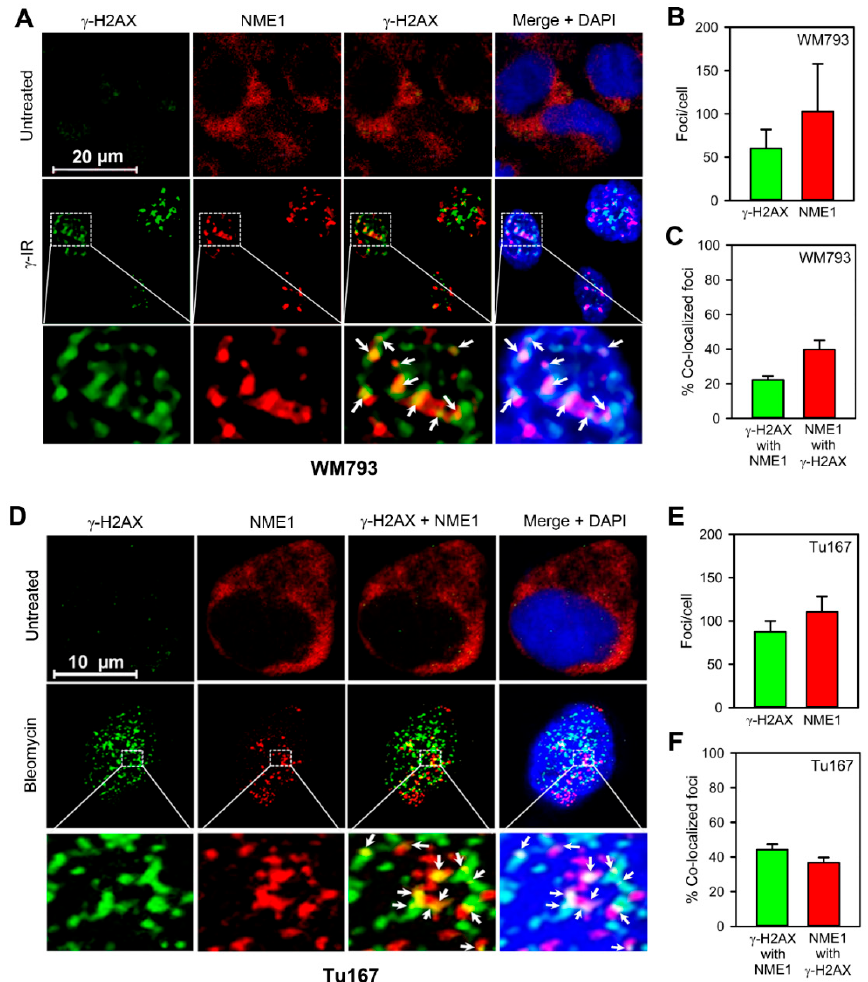
Figure 1. Induction of double-stranded DNA breaks (DSBs) induces nearly complete translocation of NME1 from the cytoplasmic compartment into DNA repair foci within the nucleus. ( A ) DSB induction in WM793 melanoma cells with γ -irradiation ( γ -IR, 8 Gy) results in co-localization of NME1 with γ -H2AX foci. Foci were assessed at 1h post-induction. Arrows denote regions of colocalization between NME1 and γ -H2AX foci. ( B ) Quantification of γ -IR-induced γ -H2AX and NME1 foci in WM793 cells. ( C ) Co-localization of γ -IR -induced γ -H2AX and NME1 foci in WM793 cells. ( D ) DSB induction in Tu167 (head and neck) squamous cell carcinoma cells with bleomycin (2 h, 20 ng / mL) results in co-localization of NME1 with γ -H2AX foci. Methods for immunofluorescence are provided in SI. Images were captured using a Zeiss 510 laser confocal microscope. ( E ) Quantification of bleomycin-induced γ -H2AX (green) and NME1 (red) foci in Tu167 cells. ( F ) Co-localization of bleomycin-induced γ -H2AX and NME1 foci in Tu167 cells. Colocalization was calculated based on centers of mass-particles coincidence using the JACoP ImageJ plugin from the ImageJ software package [32]. Results in panels ( B , C , E , F ) are expressed as mean ± S.E.M (n = 6 fields per treatment group, with at least 5 cells per field) and were derived from three independent